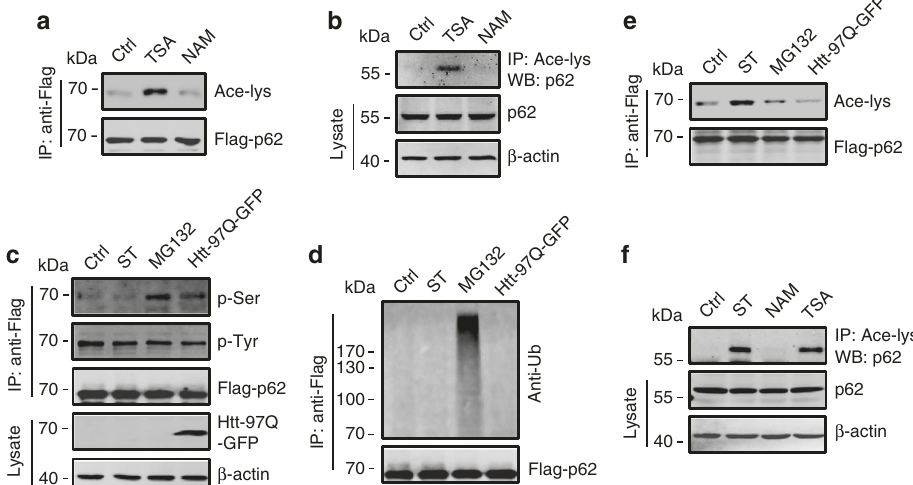
Fig. 1 Starvation induces acetylation of p62. a Acetylation of exogenous Flag-p62 in HEK293 cells treated with deacetylase inhibitors TSA or NAM. Flag- p62 was immunoprecipitated with anti-Flag, and the precipitates were analyzed using an anti-acetyl-lys antibody (Ace-lys). b Acetylation of endogenous p62 in HEK293 cells treated with TSA or NAM. p62 acetylation was analyzed by immunoprecipitation with an anti-acetyl-lys antibody followed by western blotting for p62. c – e Phosphorylation ( c ), ubiquitylation ( d ), and acetylation ( e ) of Flag-p62 in HEK293 cells incubated in starvation medium (ST), treated with proteasome inhibitor MG132, or overexpressing Htt-poly97Q-GFP. Flag-p62 was immunoprecipitated with anti-Flag and analyzed by western blot using anti-phospho-serine ( c ), anti-phospho-tyrosine ( c ), anti-ubiquitin (anti-Ub) ( d ), and anti-acetyl-lys ( e ) antibodies, respectively. f Cell starvation induces the acetylation of endogenous p62 in HEK293 cells. Source data are provided as Source Data fi